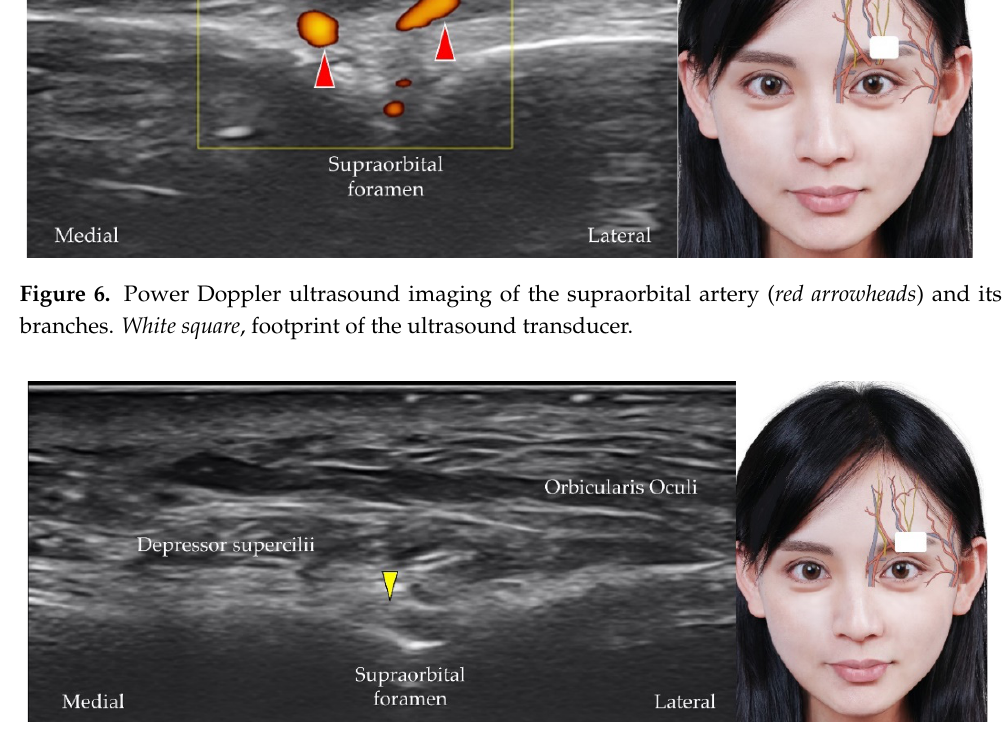
Figure 6. Power Doppler ultrasound imaging of the supraorbital artery (red arrowheads) and its branches. White square , footprint of the ultrasound transducer.